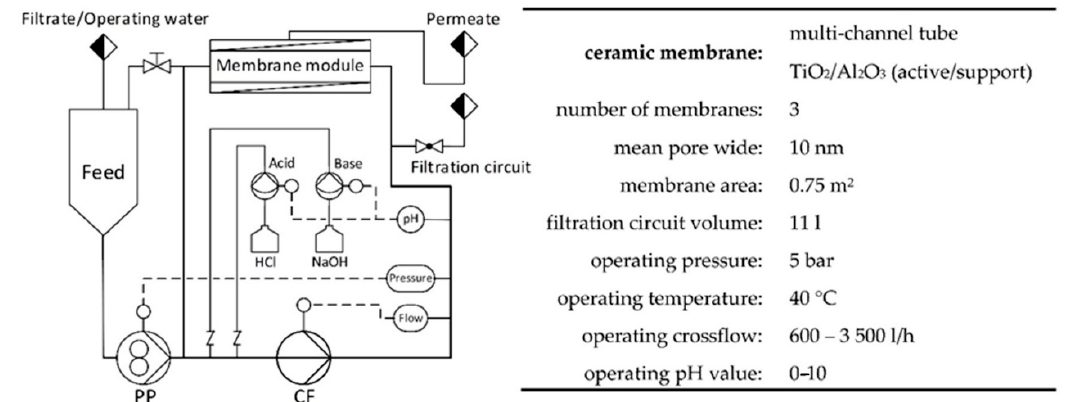
Figure 1. Scheme and operating data of tangential flow ultrafiltration pilot scale plant used for Cu(II) enrichment and separation (Andreas Junghans GmbH, Frankenberg/Sachsen, Germany). PP, pressure pump; CF, cross-flow pump.